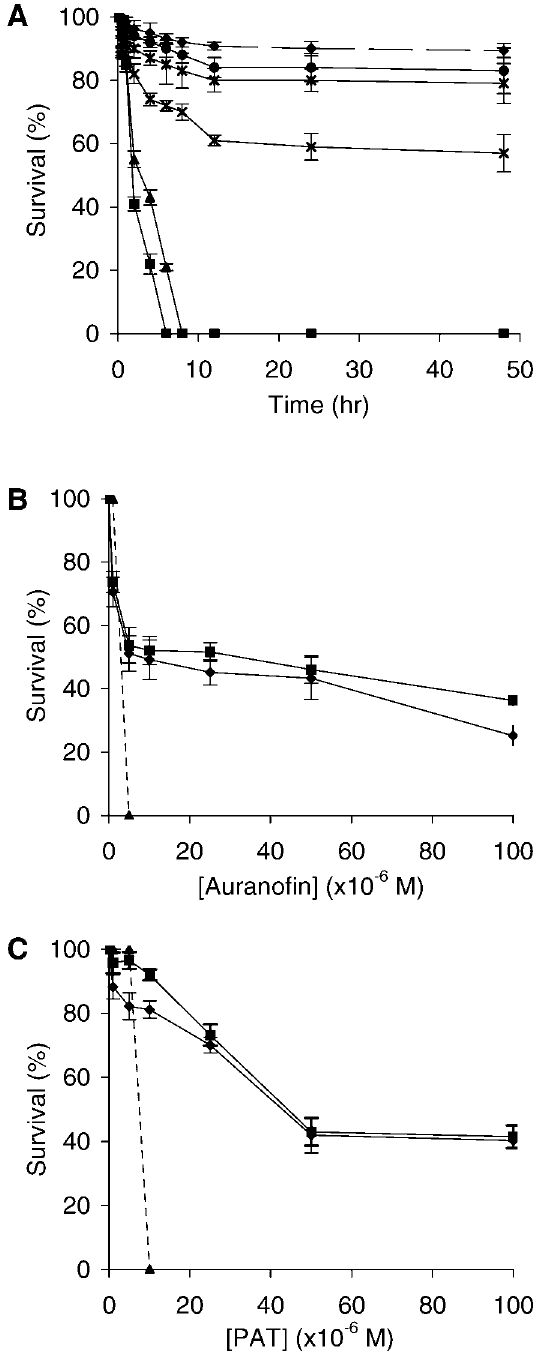
Figure 6. Survival of Schistosomula, Adult Worms, and Myeloma Cells in the Presence of Auranofin or Potassium Antimonyl Tartrate (A) Cultured schistosomula treated with 0 l M AF (dashed line); AF 0.5 l M ( ¤ ); 1 l M (*); 2 l M (x); 5 l M ( m ); 10 l M ( & ). (B) Survival of adult Schistosoma mansoni worms at 24 h (dashed line), myeloma cells at 24 h ( & ); and myeloma cells at 5 d ( ¤ ) at given concentrations of AF. (C) As in (B) in the presence of given concentrations of PAT. Each treatment was done in triplicate and each experiment was done three times. Error bars show the standard deviation of the three replicate experiments.